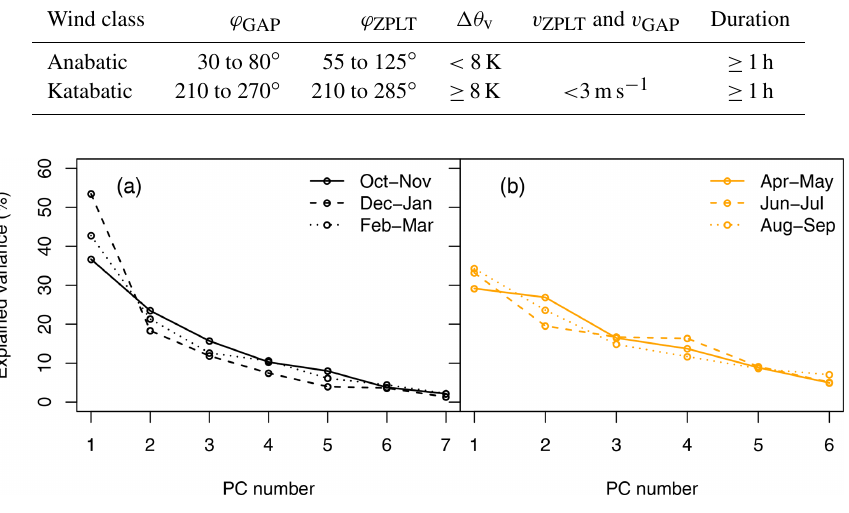
Figure 5. Percentage of explained variance as a function of the principal component (PC) number for each 2-month period: (a) winter half year and (b) summer half